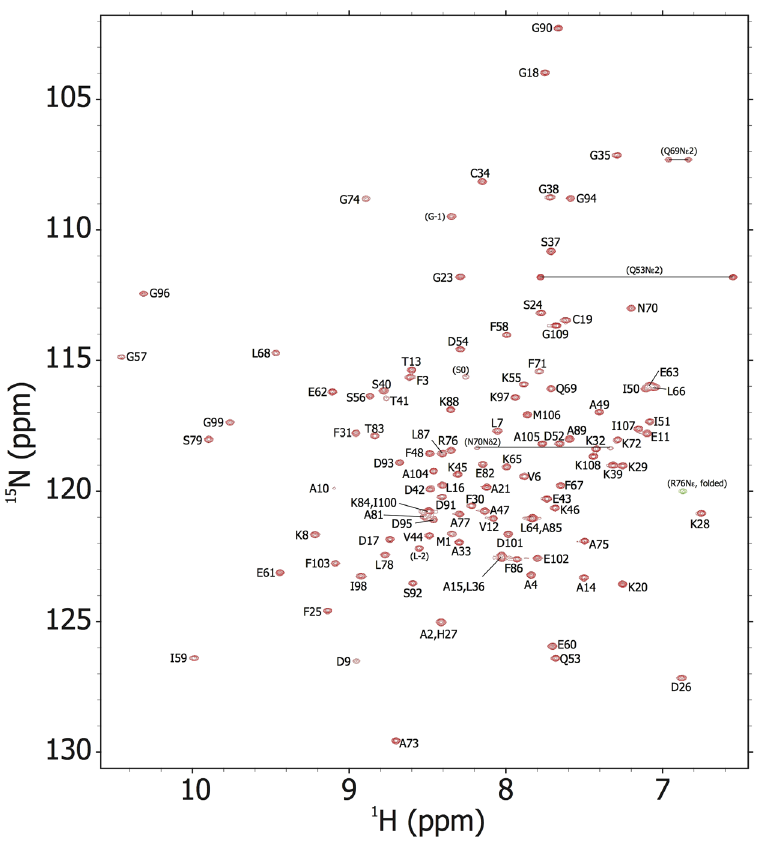
Figure 1. [ 1 H- 15 N] HSQC spectrum of the Pacific mackerel parvalbumin Sco j 1, with resonance